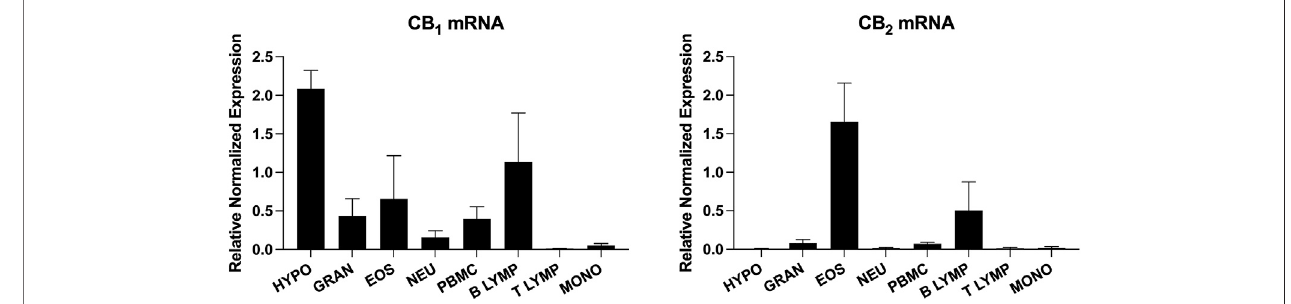
FIGURE 1 | Expression of the CB 1 and CB 2 receptors mRNA in human leukocytes isolated from the blood. Human venous blood was collected from healthy volunteers with the informed consent of all participants in blood collection tubes containing K 3 EDTA as anticoagulant. Granulocytes (GRAN), eosinophils (EOS) and neutrophils(NEU)wereisolatedasinChouinardetal.(2013).PBMCswereobtainedfromthePBMClayerandtakenasisorotherwiseprocessedformonocyte(MONO), BandTlymphocytes(LYMP)isolationusingtheEasySep ™ monocyteisolationkit,CD19positiveSelectionKitIIandCD3positiveselectionKitIIrespectively,asper the manufacturer ’ s protocol. Purity of the different isolated leukocytes was always > 97% with the exception of B Lymphocytes (90%) with MONO being the main contaminant. Hypothalamus (HYPO) samples were obtained from the Douglas-Bell Canada Brain Bank (McGill University, Montréal, Canada). mRNA was next isolated from the different preparations with TRIzol as per the manufacturer ’ s protocol. 500 ng of total RNA was reverse transcribed using a High-Capacity cDNA Reverse TranscriptionKit(AppliedBiosystems,CA,USA)asrecommended.qPCRanalyseswere fi nallyperformedonaCFXConnectReal-TimePCRSystem,usingthefollowing primers (forward - reverse): GAPDH (5 ′ -ACATCGCTCAGACACCATG-3 ′ – 5 ′ -TGTAGTTGAGGTCAATGAAGGG-3 ′ ) 18S (5 ′ -CGCACGGCCGGTACAGTGAA-3 ′ – 5 ′